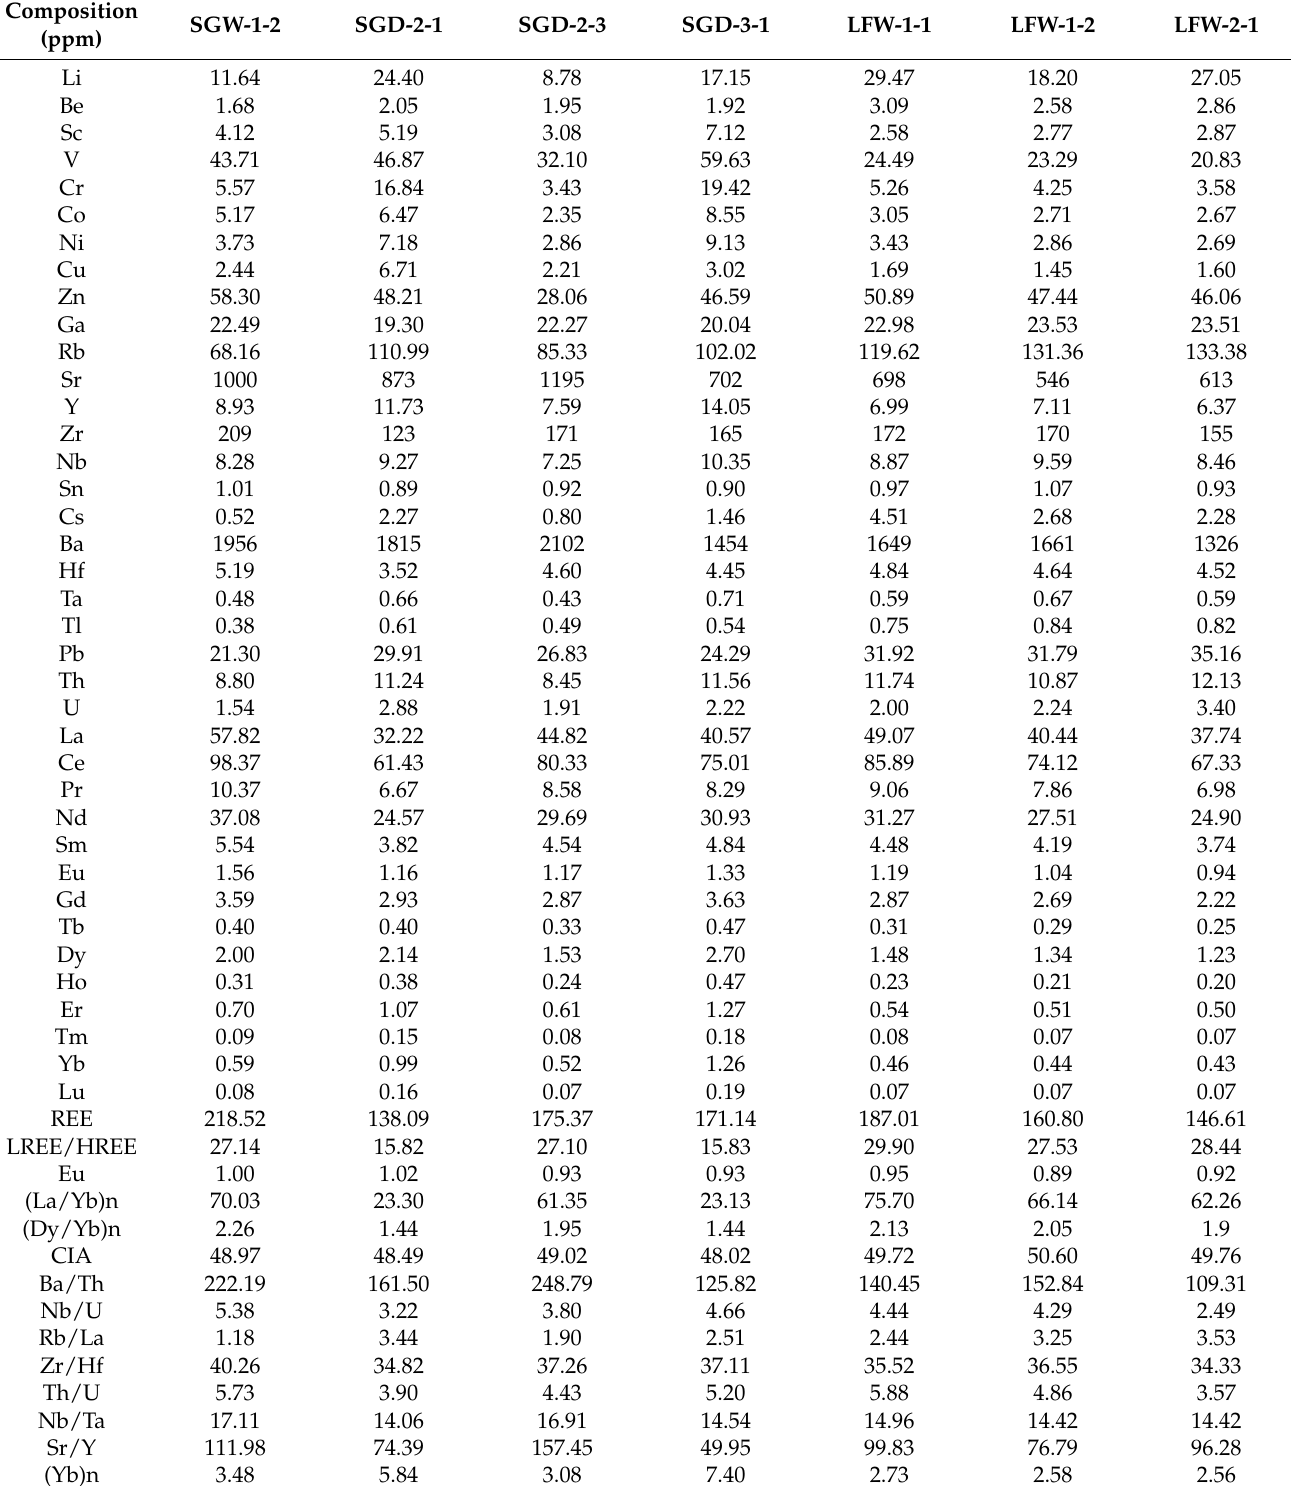
Table 2. Trace element compositions of Shangcheng adakitic